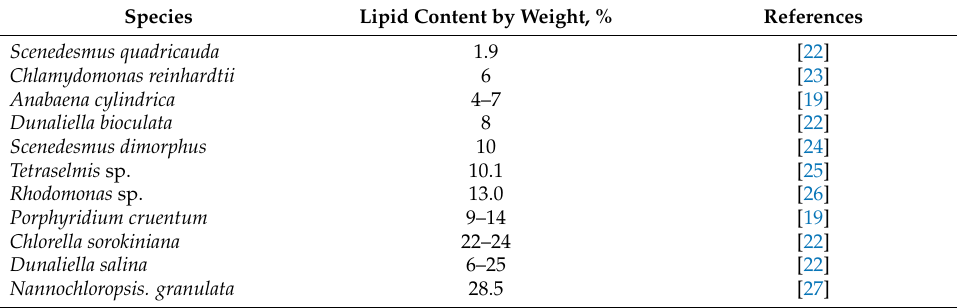
Table 3. Lipid content in microalgal